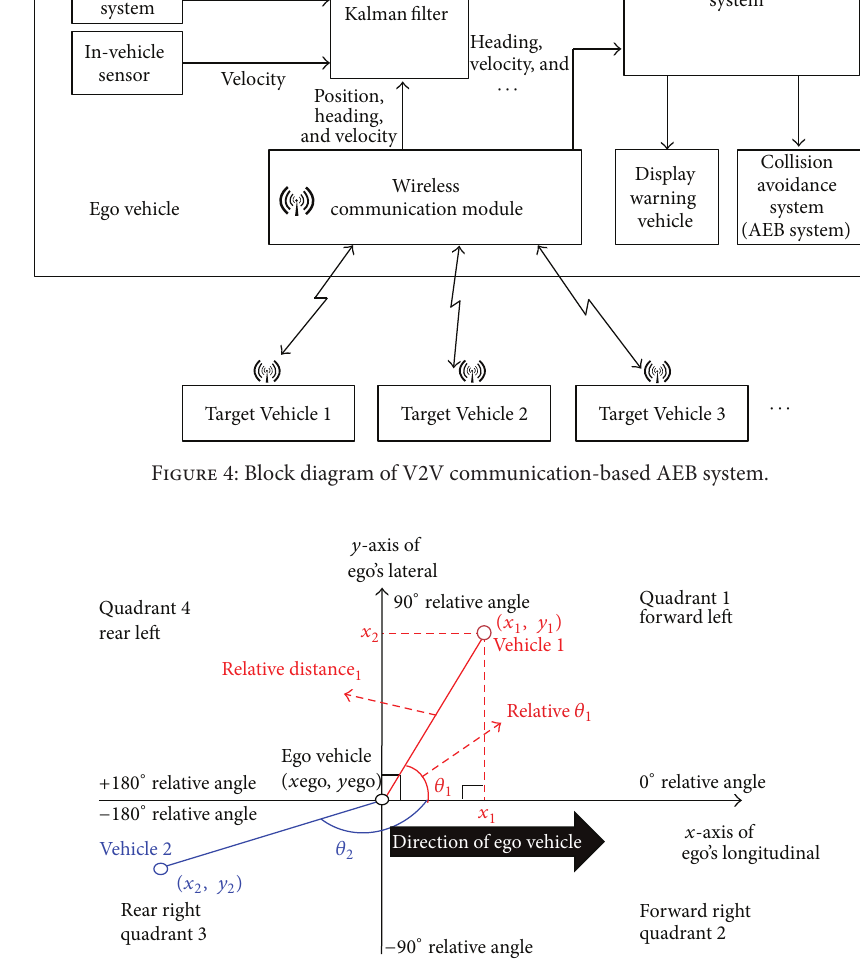
Figure 5: Principle of collision detection system.